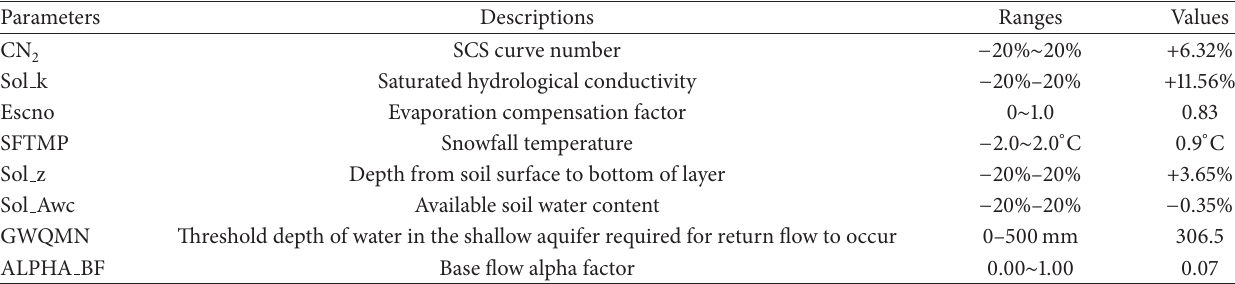
Figure 4: The calibration and validation of monthly discharge at the Yingluoxia hydrological station, observed versus simulated using the SWAT. Table 2: Ranges and values of the most sensitive parameters in SWAT